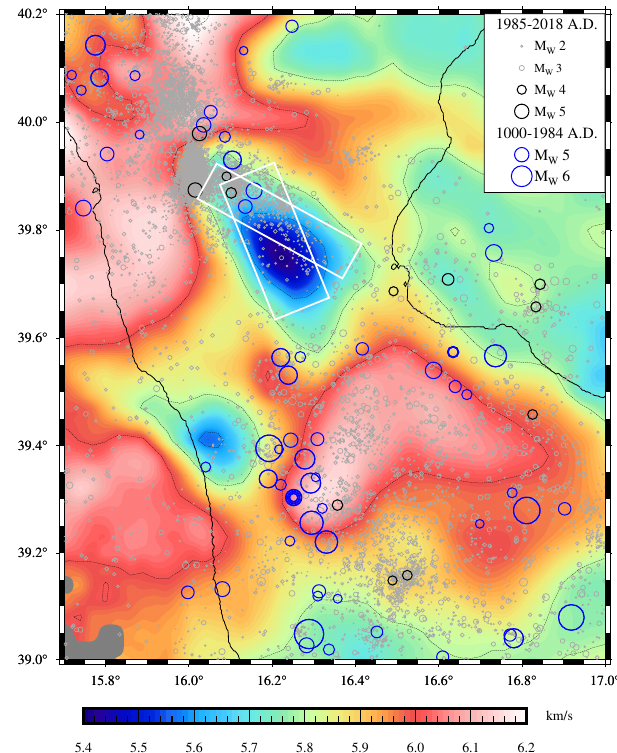
Figure 2. Historical (from 1000 to 1984, blue circles) and recent (from 1895 to present, gray and black circles) earthquakes from the CPTI11 and ISIDe catalogs [28,29]. The velocities of the seismic P-waves at 9km depth from Totaro et al. [23] are shown in the